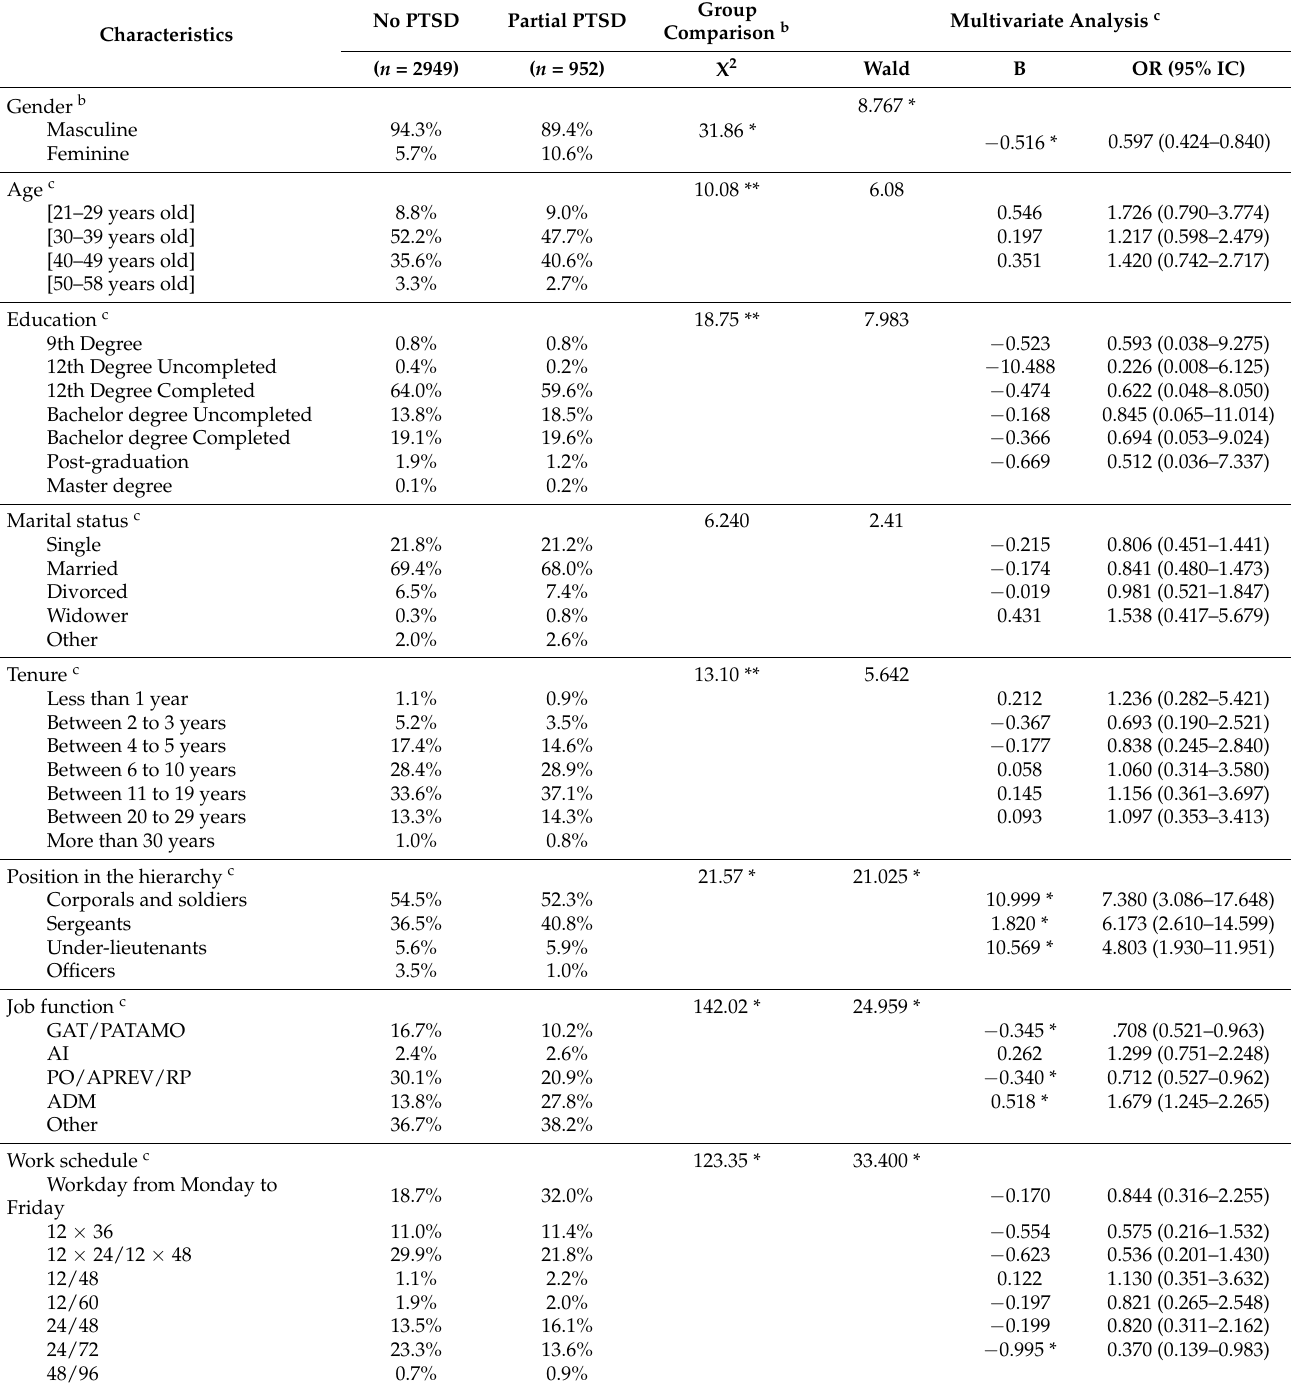
Table 2. Relationships among partial post-traumatic stress symptoms status and socio-demographic and work-related